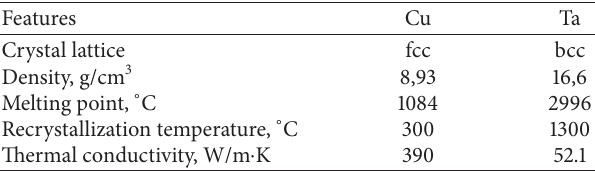
Figure2: General view (a)andschematicdiagram (b)ofCu-Tajoint produced by explosive welding. Table 1: Some properties of copper and